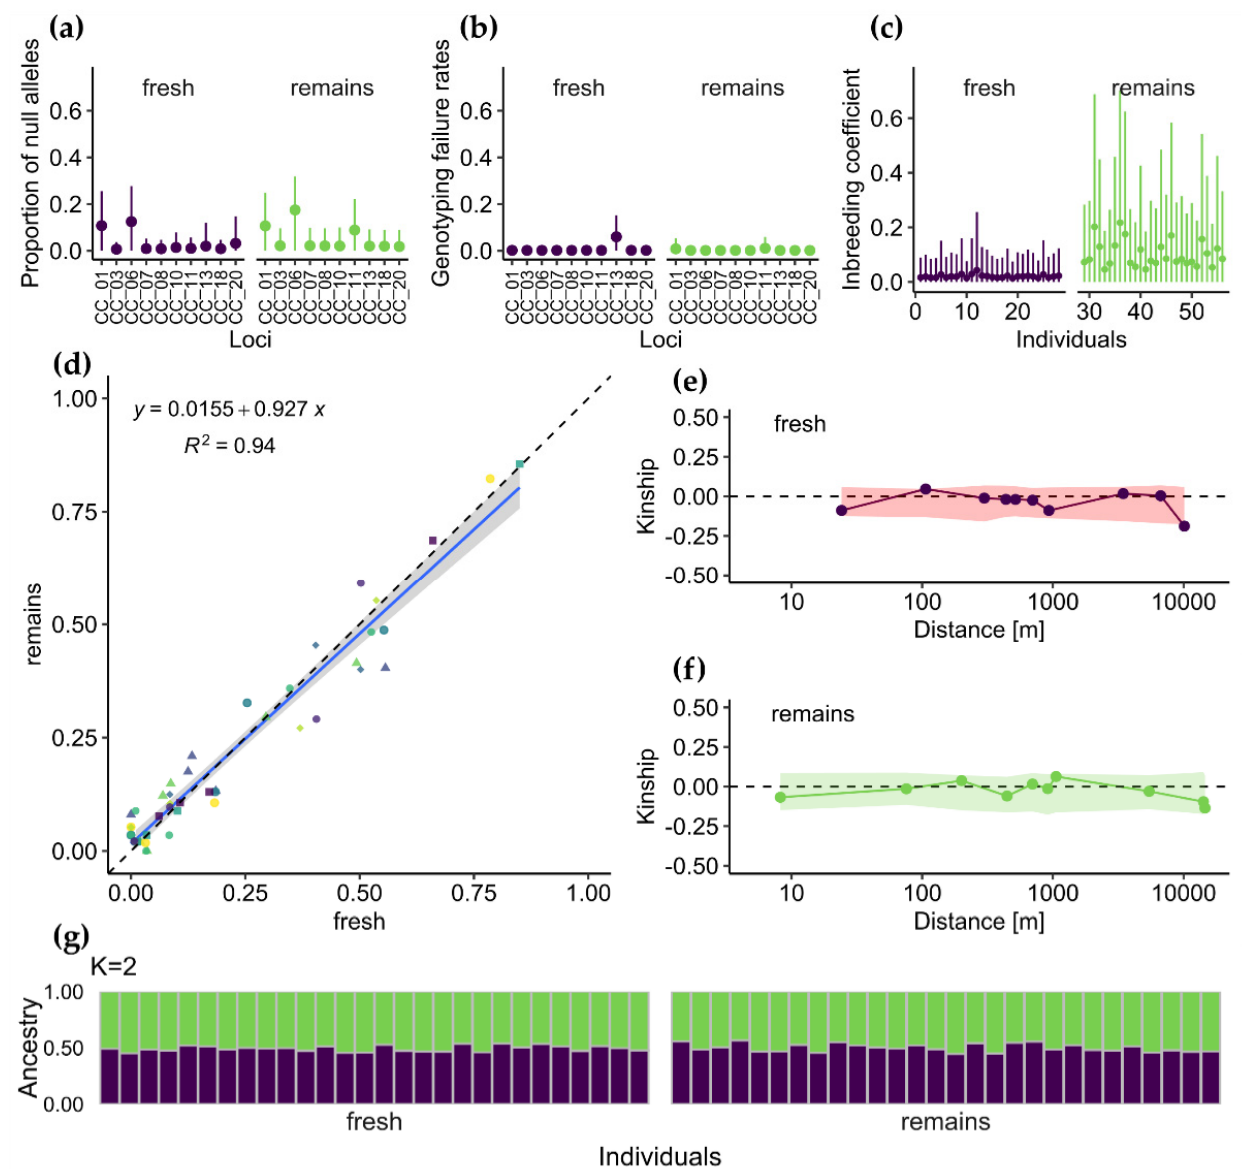
Figure 3. ( a – c ) Results from INEst [35] analysis showing ( a ) proportion of null alleles and ( b ) genotyping failure for loci tested, and ( c ) estimated individual inbreeding coefficient, f i . ( d ) Relationship between allele frequencies in fresh and remains samples (colours and shapes correspond to alleles at different loci). ( e , f ) Average kinship coefficients between pairs of individuals plotted against geographical distance for ( e ) fresh and ( f ) remains samples. Points show observed value of pairwise kinship coefficient for mean value of each distance class, while shaded areas around zero represent 95% confidence interval obtained under the null hypothesis that genotypes are randomly distributed. ( g ) Graphical output from STRUCTURE [38]. Each vertical bar represents an individual, and the colour composition displays the probability of belonging to each of the two clusters defined by STRUCTURE.